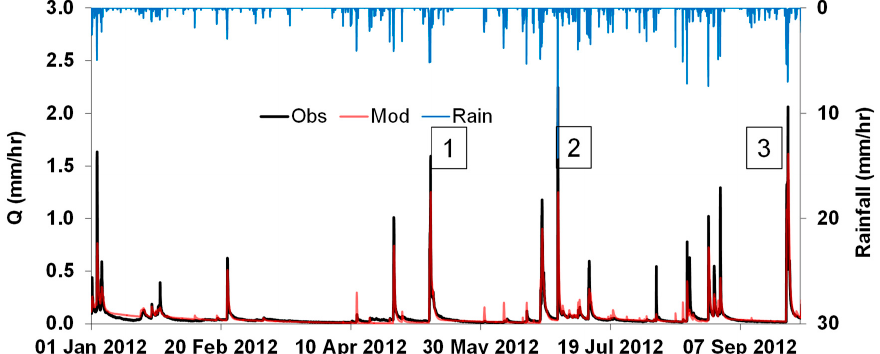
Figure 5. Time series plots of observed (“Obs”) and modelled (“Mod”) (baseline) runoff plus rainfall at the NBC outlet from January – September 2012.